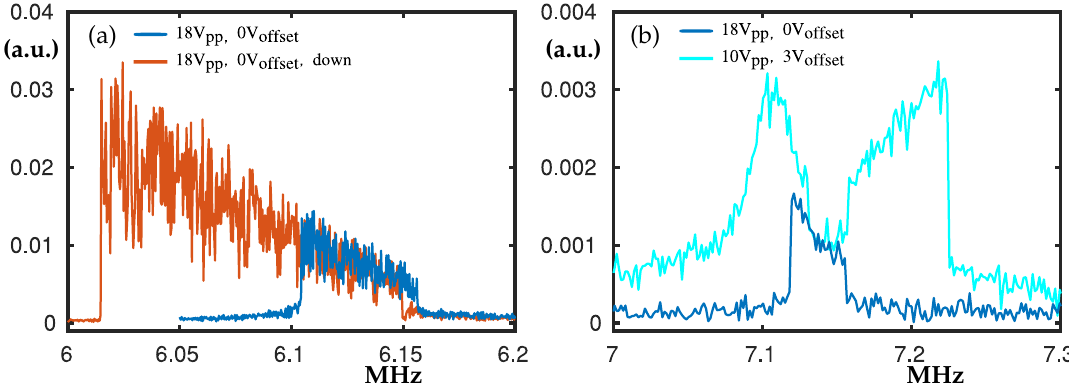
Figure 4. Experimental frequency swipes centred at about 6.1 MHz and 7.1 MHz. In panel ( a ), V pp = 18 V, V of f = 0 V where, the blue curve denotes swipe-up and the red curve denotes swipe-down. In panel ( b ) the blue and cyan curves denote V pp = 18 V, V of f = 0 V and V pp = 10 V, V of f = 3 V,